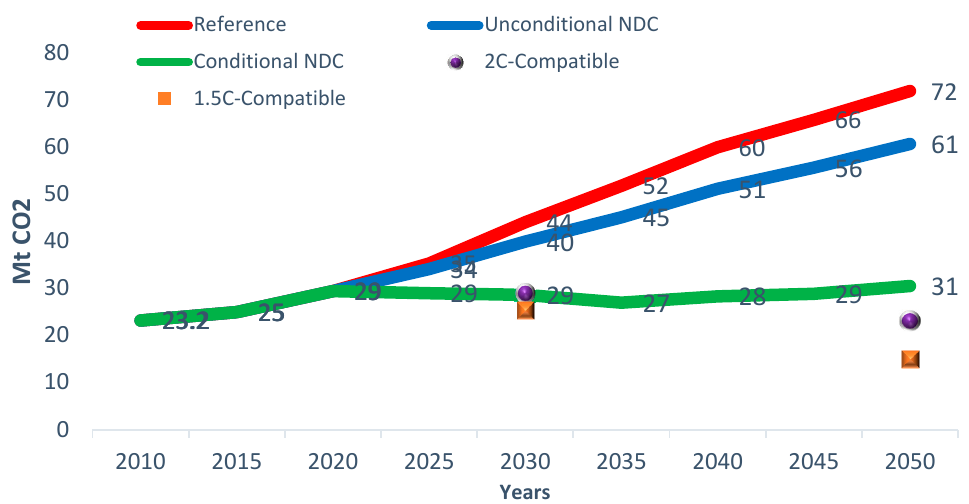
Figure 10. CO 2 emission pathways in Tunisia under NDC and Paris-compatible scenarios in 2010– 2050. Source: MENA-EDS Model, Author estimates.